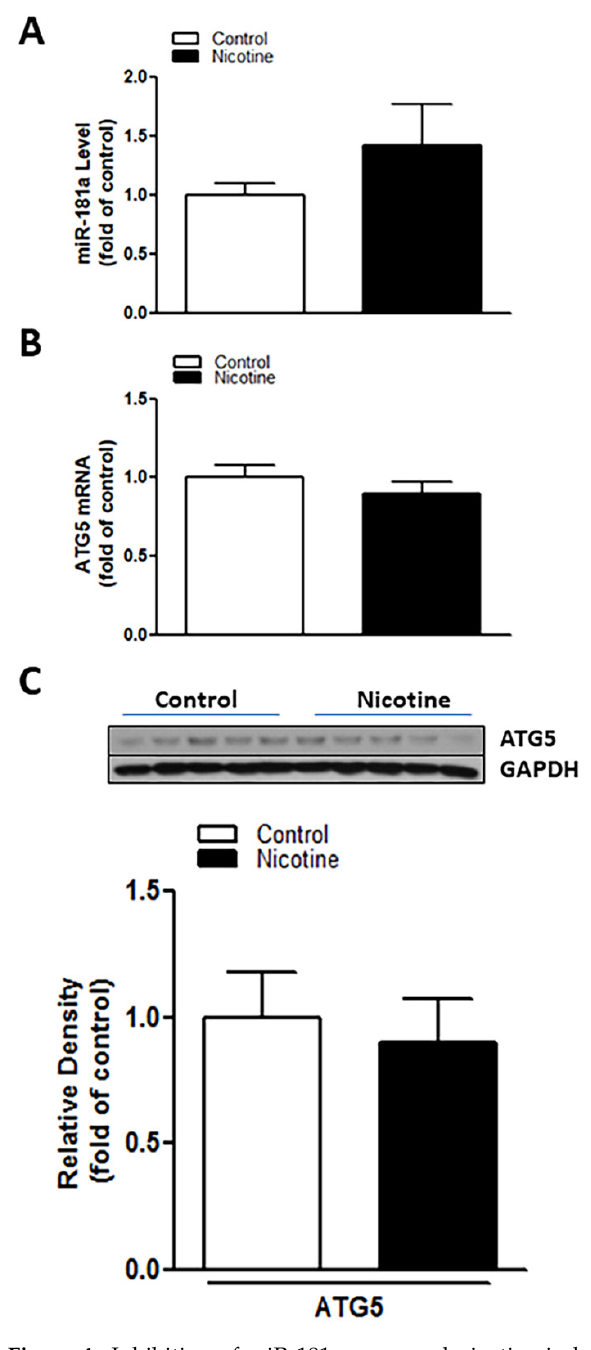
Figure 4. Inhibition of miR-181a recovered nicotine induced aberrant miR-181a/ATG5 levels in neonatal rat brain. LNA-MiR-181a was administered intracerebroventricularly (i.c.v.) on P7 pups. Brain was isolated on P9. qRT-PCR analysis was employed to evaluate levels of miR-181a ( A ) and ATG5 mRNA ( B ), respectively. ATG5 protein abundance ( C ) was determined by Western blotting. As shown in this figure, LNA-miR-181a administration decreased miR-181a expression and eliminated the differences of both protein and mRNA levels of ATG5 in neonatal brains between the nicotine exposed and saline control groups. Data are means ± SEM. n = 5 animals/group.